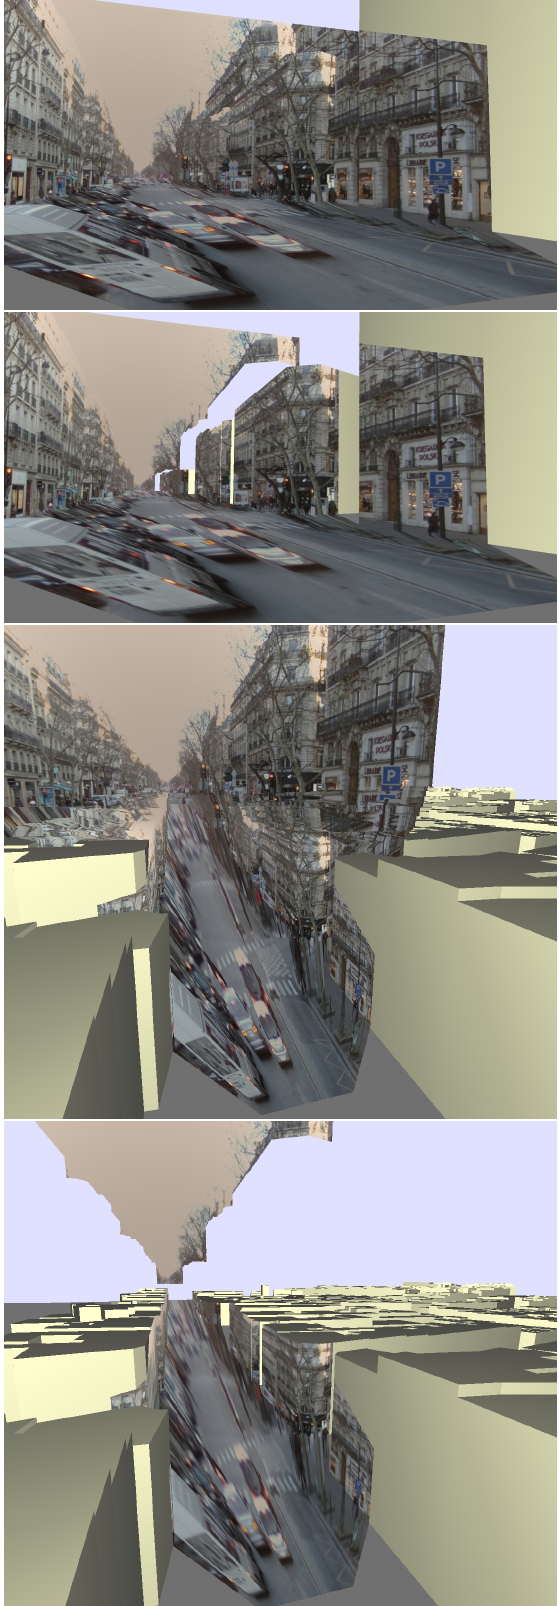
Figure 4: Rows 1 and 3: Regular projective texturing does not only texture the surface closest to the projective centers. Rows 2 and 4: Occlusion handling prevents the texturing of occluded